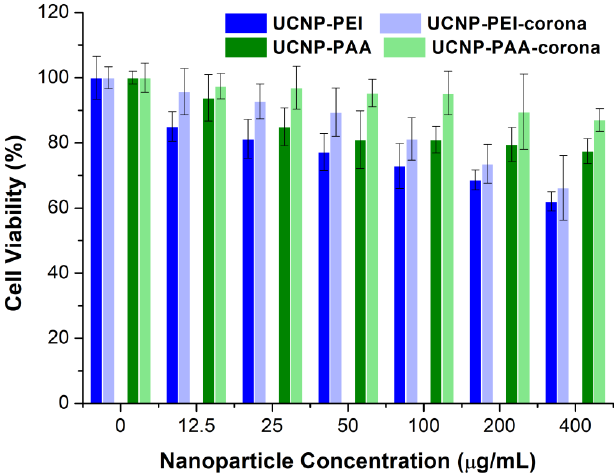
Figure 9. Cell viability data of MDA-MB-231 cells after treatment with polymer-coated and corre- sponding PC-modified UCNPs at concentrations ranging from 0 to 200 µg/mL for 24 h. Results of MTT assay, value format, mean ± standard deviation.